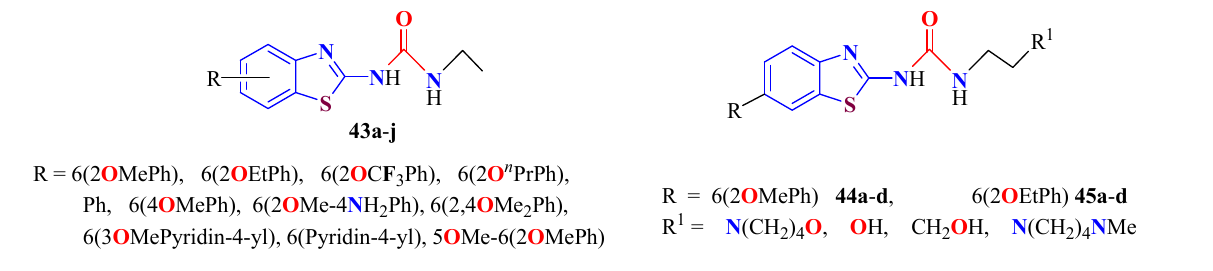
14 of 40 tested against six major Gram-positive pathogens, exhibiting potent inhibition with MIC 90 values from 0.015 μ g/mL for S . pneumoniae to 0.25 μ g/mL for S . aureus , compared with the MIC 90 values of 2 μ g/mL and 4 μ g/mL, respectively, for linezolid and 16 μ g/mL and 16 μ g/mL, respectively, for levofloxacin. The tested compounds were also potent against S . aureus drug-resistant strains, including VRE, MRSA, VRSA, linezolid-non-susceptible S . aureus , daptomycin-non-susceptible, methicillin-resistant S . epidermidis , penicillin re- sistant S . pneumoniae , and FQ- S . pneumoniae strains. Moreover, no cross-resistance was ob- served caused by the mechanisms responsible for conferring resistance to these antibiot- ics. Both compounds also showed a promising pharmacokinetic profile in rats and mice [78]. Two additional patents described the synthesis of 4-fluoro-5,7-disubstitutedbenzo- thiazole ureas as compound 42 [75]. All compounds were tested for their DNA supercoil- ing assays for GyrB inhibition and a DNA relaxation assay for ParE inhibition. Under both assay conditions, few compounds showed activity in the sub-micromolar range (IC 50 val- ues 30–550 nM) and were found to be active in antibacterial assays against Gram-positive pathogens. The same procedure was used to synthetize a series of 6-substituted-ethylUBTs 43 , 44 and 6-substituted-R 1 ethylUBTs 45 as effective inhibitors against wild-type (wt) and T 315 I mutant Bcr-Abl Kinases, Scheme 17 [143]. Through a structure-based drug